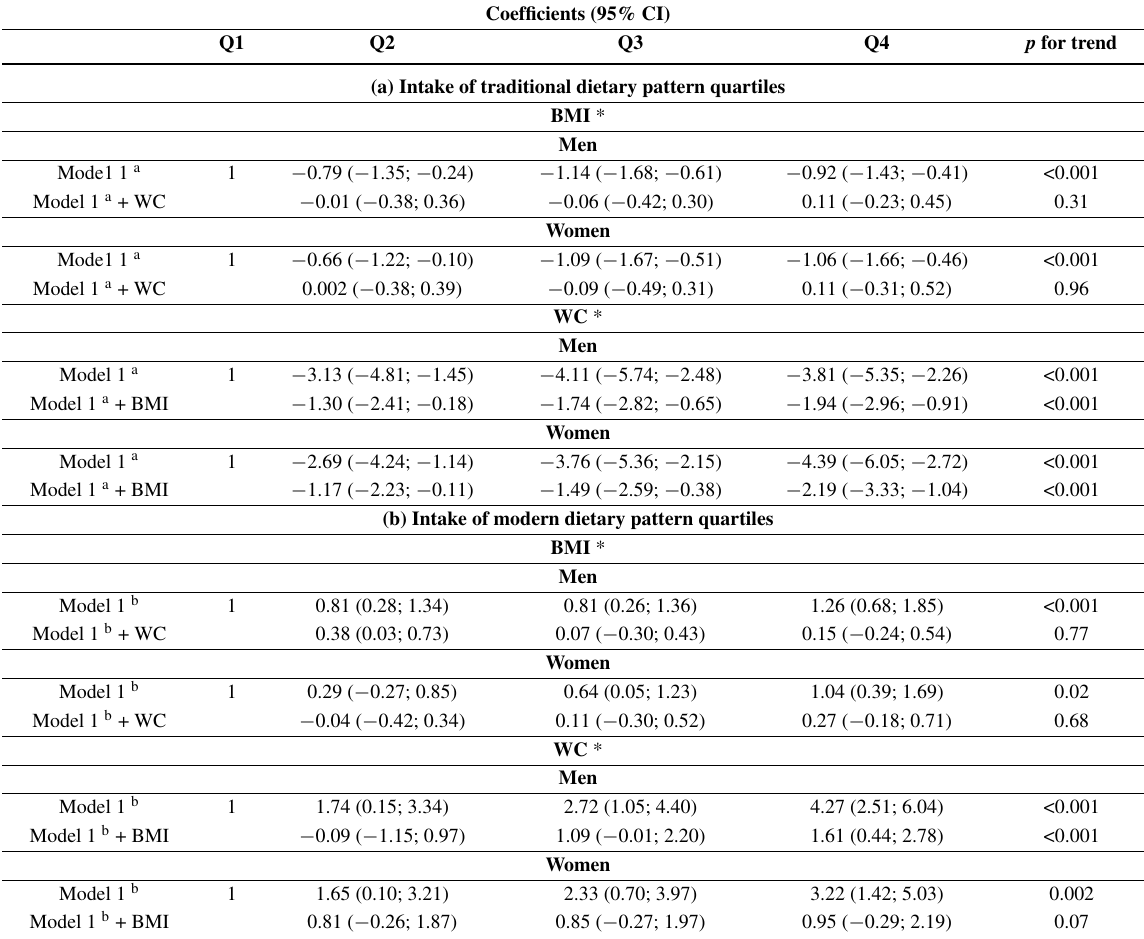
Table A1. Associations between dietary patterns and